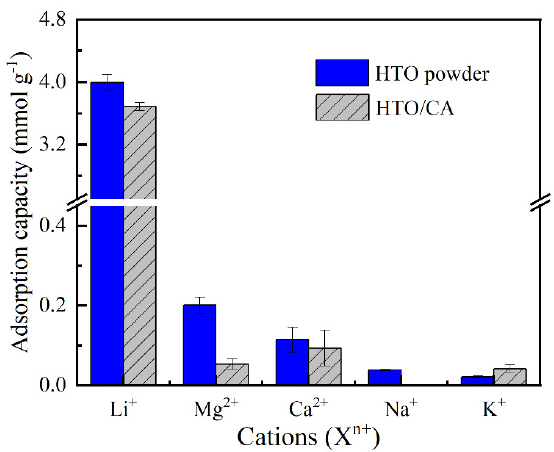
Figure 9. Effect of HTO loading on the selectivity of HTO/CA toward Li + adsorption using a solution containing a mixture of cations (X n+ = Li + , Na + , Mg 2+ , K + , Ca 2+ ) (pH = 10.25; V = 160 mL; m ≅ 100 mg; C 0 = [X n+ ] ≅ 50 mg L − 1 ).